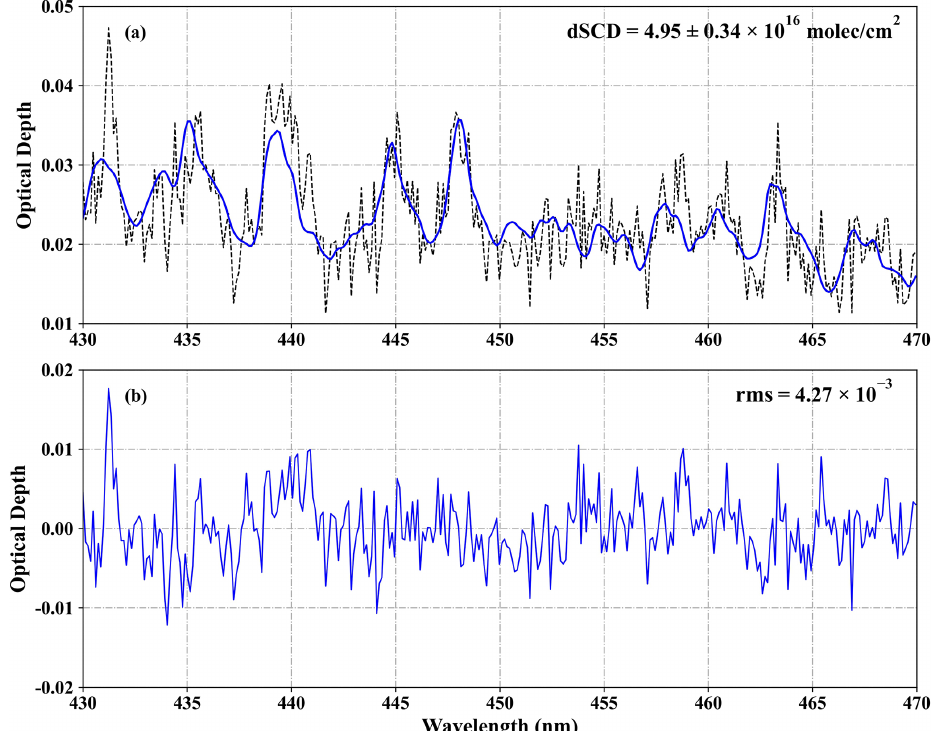
Figure 6. Sample DOAS fit result for NO 2 : (a) observed (dashed black line) and fitted (blue line) optical depths from measured spectra; (b) the remaining residuals of DOAS fit.